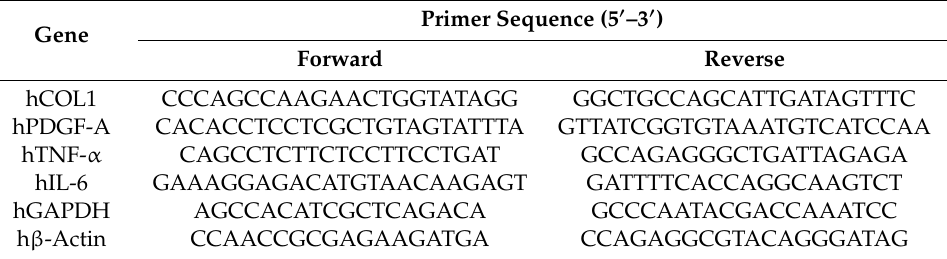
Table 1. Primers for quantitative